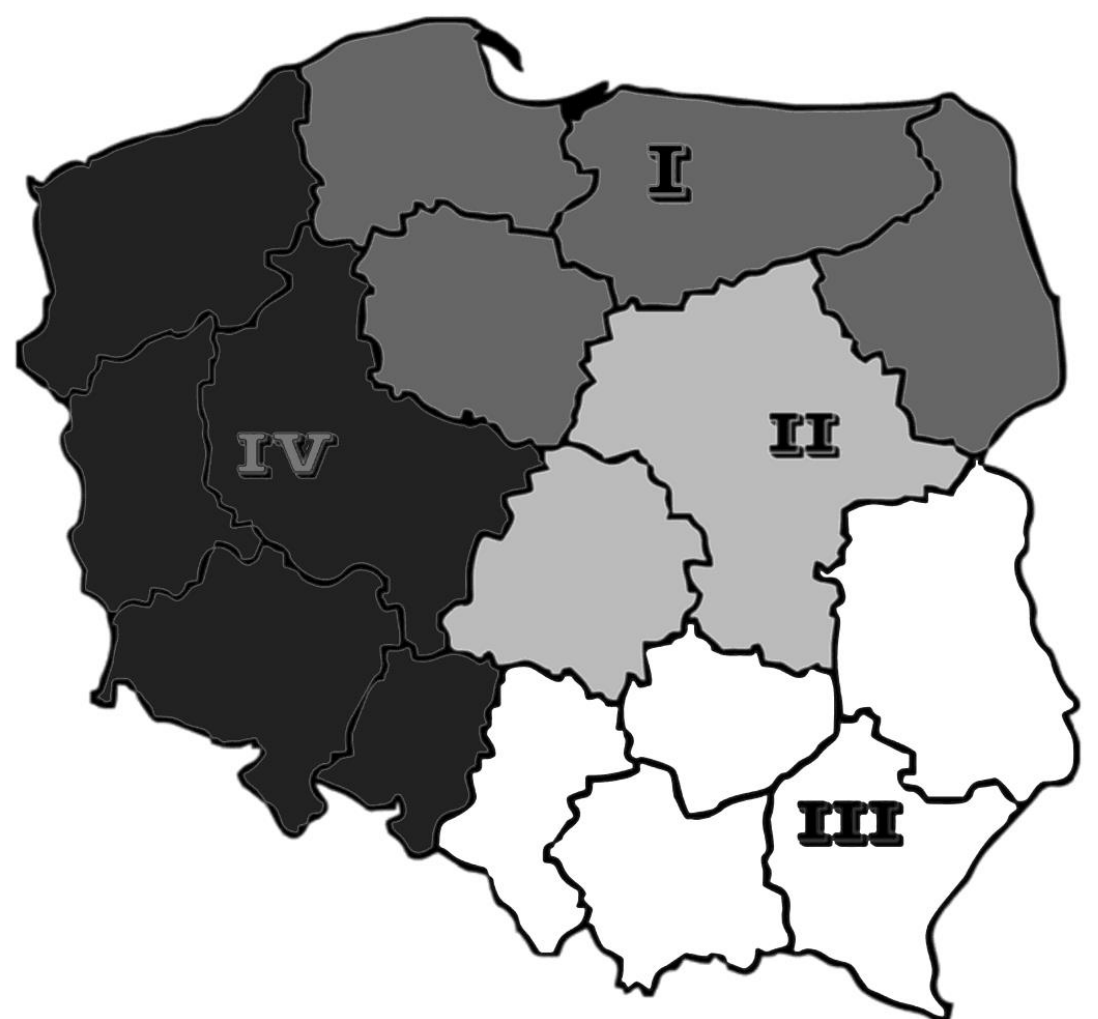
Figure 1. Price reporting regions for butter and curd in Poland. Note: Northern and Central regions are the focus of the study. Source: Prepared by authors.